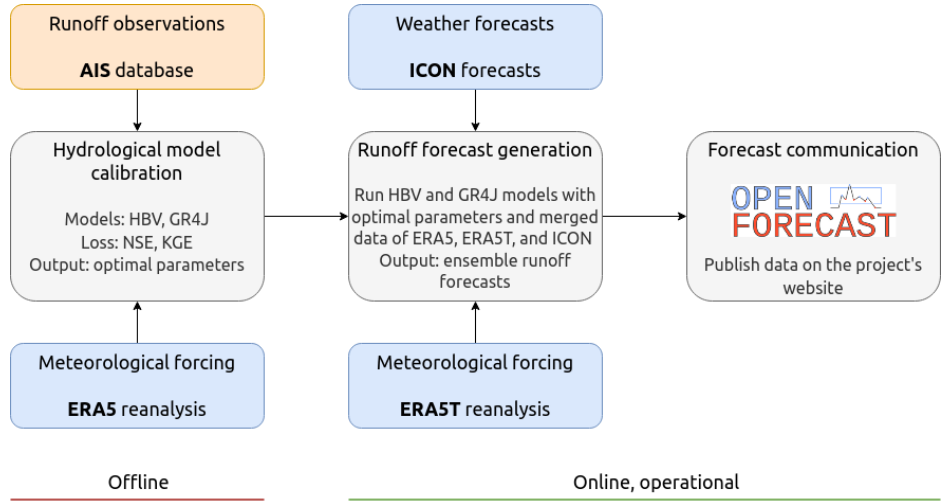
Figure 1. Illustration of the OpenForecast computational workflow.